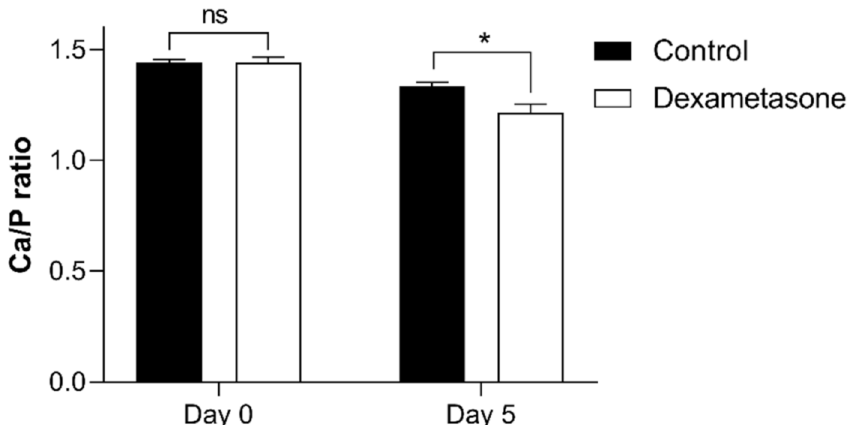
Figure 7. Ca/P ratio of zebrafish scales on day 0 and day 5 of the experiment from the control (black bar) and dexamethasone groups (white bar). Ten scales from each were collected and measured the calcium and phosphorus levels using ICP-MS. Values are presented as the mean ± SEM using Student’s t -test, with * p ≤ 0.05; ns: not significant. Error bars indicate the standard error of the